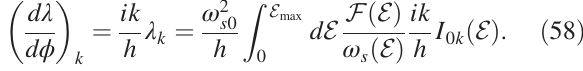
FIG. 8. The real part of the normalized mode frequency found from macroparticle simulations using BL on D (colors) and from MELODY (red dotted line) as a function of bunch intensity for a broadband resonator impedance with Im Z=k ¼ 0 . 07 Ω , Q ¼ 1 , f 8 GHz (right). The maximum incoherent frequency obtained from MELODY is shown with black solid line. The dashed red and f r ¼ lines indicate the LLD intensity thresholds. Calculations done for η > 0 , V 0 ¼ 6 MV, μ ¼ 2 , zero-intensity τ 4 σ ¼ 0 . 82 ns, and m ≤ 5